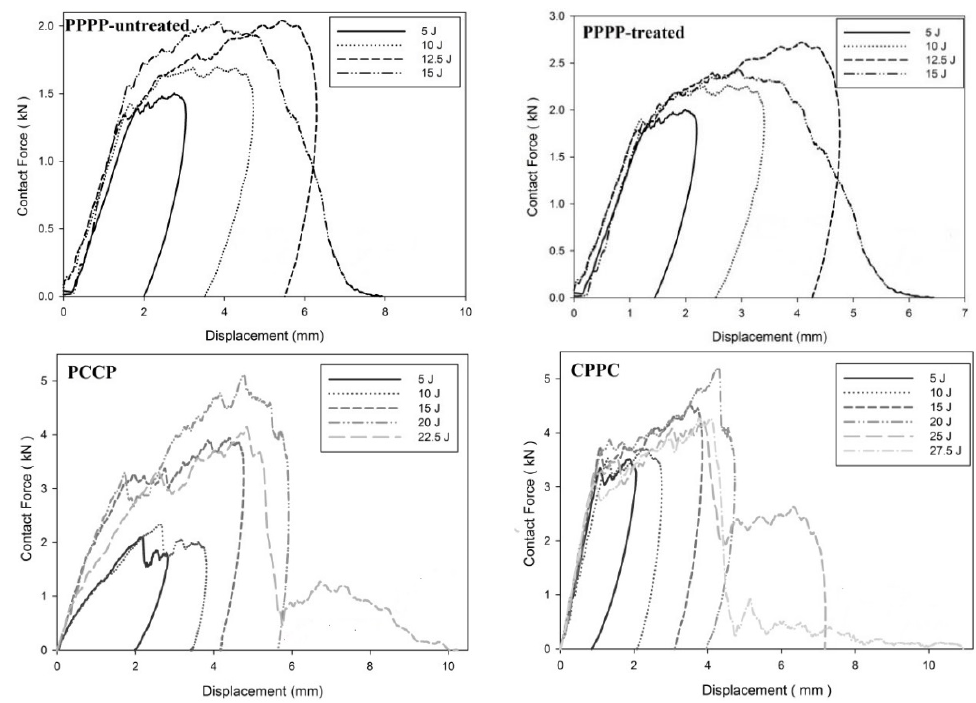
Figure 3. Contact force–displacement of the hybrid laminates at ply orientations of [0°, 90°] 8 .